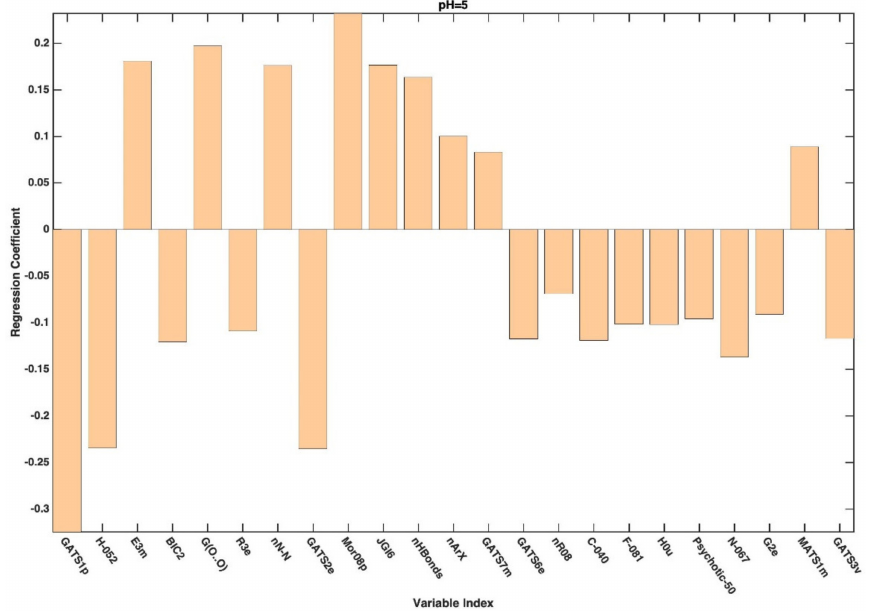
Figure A2. Regression coefficients associated to the descriptors selected by CovSel for the PLS-DA model based on the reduced dataset collected at pH